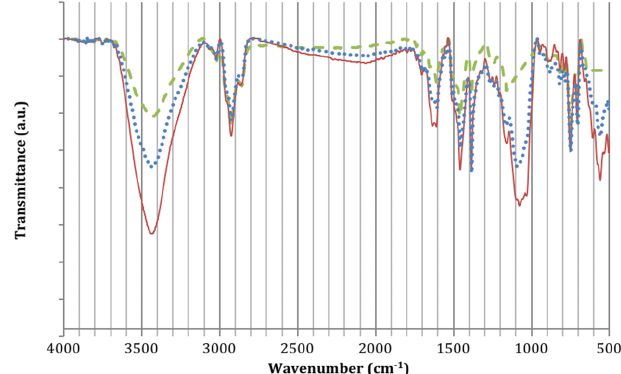
Figure 12. Infrared spectra (4000–400 cm − 1 ) of metallic (silver) graffiti on granite in the accelerated ageing induced by NaCl salt cycles. The dotted blue line of the spectrum corresponds to the beginning of the treatment, the dashed grey line to the 7th cycle and the continuous orange line to the 14th cycle.